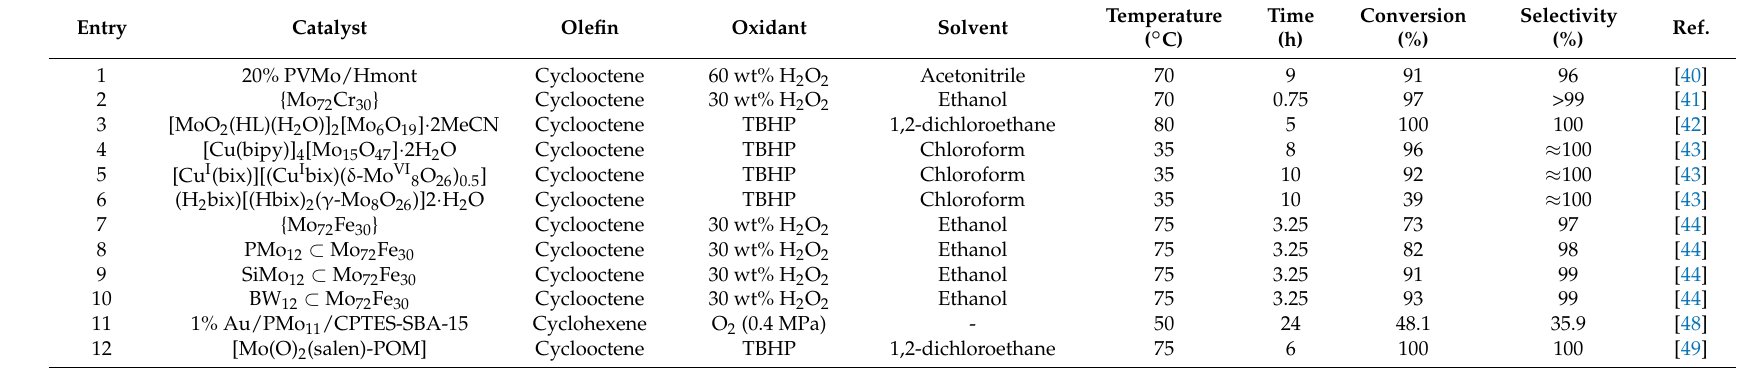
Table 2. Results of epoxidation reactions by using polyoxometalates (POMs)